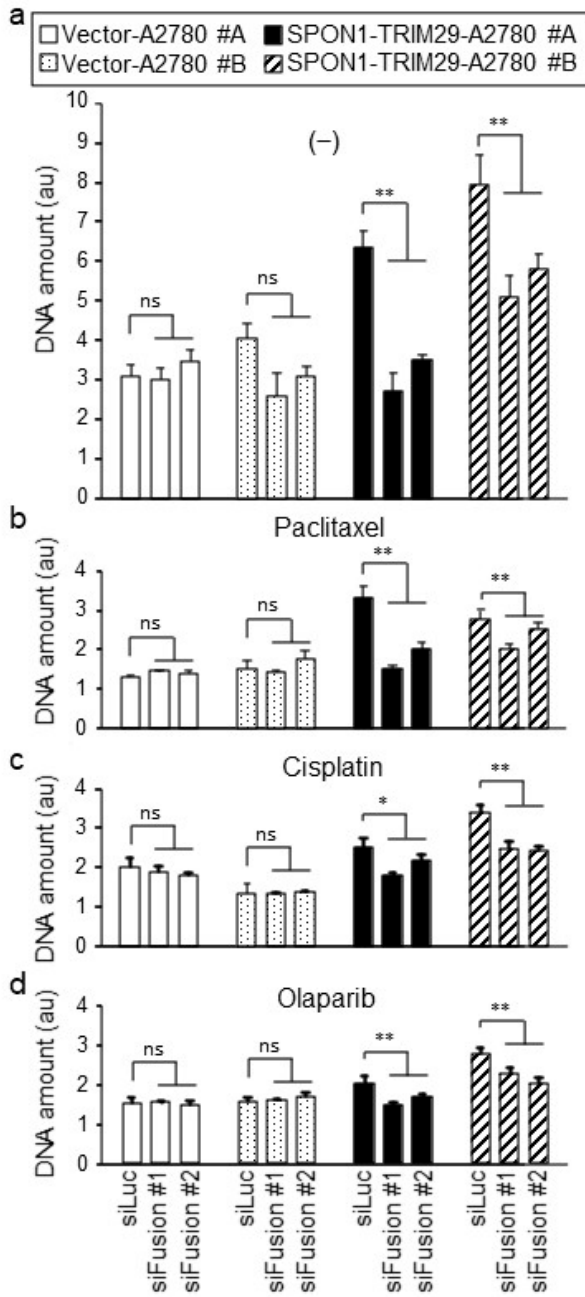
Figure 4. SPON1-TRIM29 blockade impairs cancer drug-resistant growth in SPON1-TRIM29-A2780 cells. SPON1-TRIM29- and Vector-A2780 cells were treated with siRNAs specific for SPON1-TRIM29 joint sequence (siFusion #1 and #2) or control siRNA (siLuc), and treated with vehicle ( − ) ( a ), 1 µ M cisplatin ( b ), 5 nM paclitaxel ( c ), or 2 µ M olaparib ( d ). Cell growth was estimated by DNA assay. Data are presented as means ± SD ( n = 5). * p < 0.05; ** p < 0.01, Student’s t -test. ns, not signif- icant.